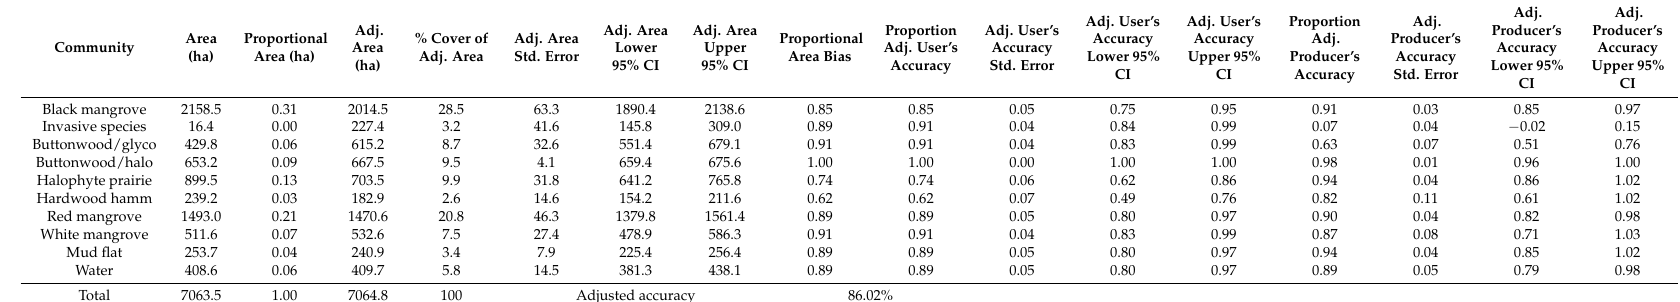
Table 3. Original and adjusted area and accuracy of classified community types in the 71 km 2 study area, Flamingo, Everglades National Park, Florida. Columns are original mapped area (ha), proportion of area covered (ha), adjusted area (ha), adjusted area %cover, unadjusted community area bias proportion, proportion adjusted user’s and producer’s accuracies, standard errors, and upper and lower 95% confidence intervals. Because it was difficult to distinguish pixels of the two invasive species, Schinus terebinthifolius and Colubrina asiatica , and their area was small, we combined those two categories (called Invasive species in the table) for the accuracy assessment. Community types are described in the text: Buttonwood/glyco = Buttonwood/glycophyte; Buttonwood/halo = Buttonwood/halophyte; Hardwood hamm = Hardwood hammock.